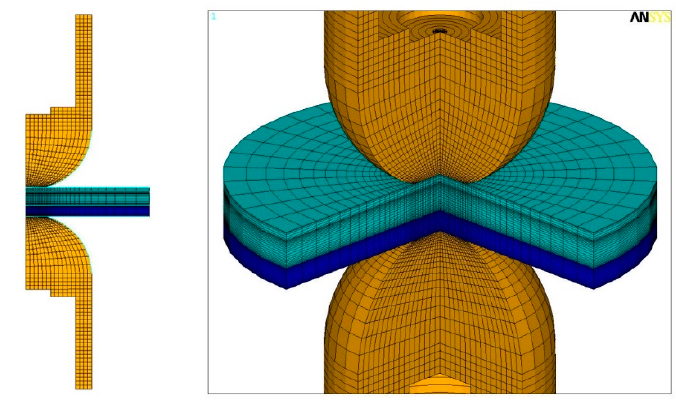
Figure 3. Weld nugget configuration in weld-bonding of three steel sheets. 4. Finite Element Modeling 4.1. Geometric Model A computational model using commercial software ANSYS 15.0 is developed to describe the coupled electrical-thermal-mechanical behavior of the weld-bonding process. The physical